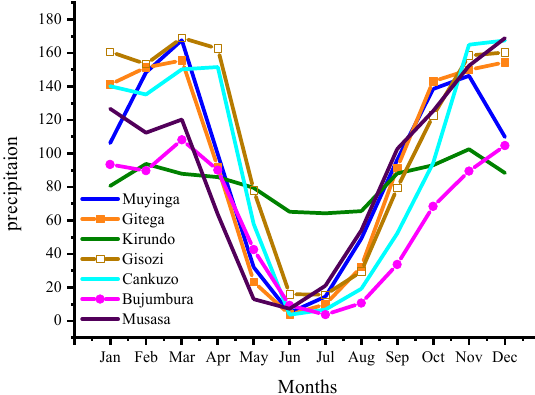
Figure 3. Monthly mean precipitations in mm for the seven meteorological stations in this study.